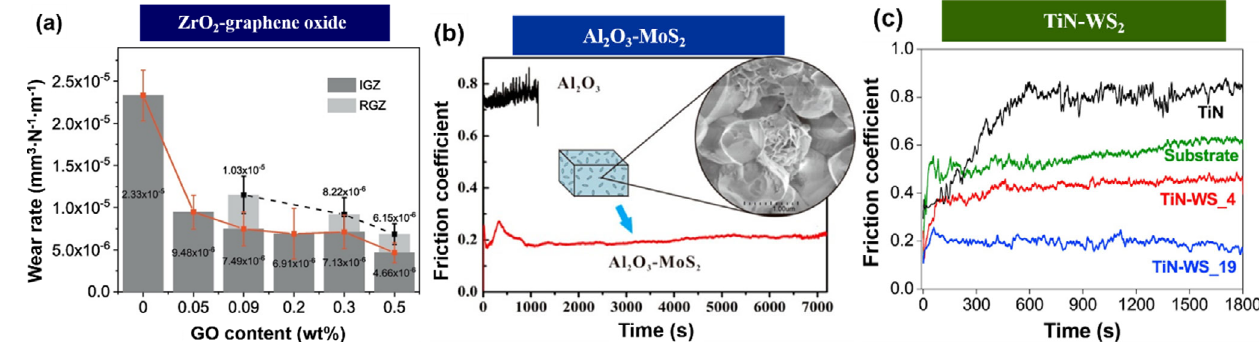
Fig. 11 (a) Specific wear rates of ZrO 2 and ZrO 2 –GO (IGZ: in situ reduced graphene oxide reinforced 3 mol% yttria stabilized zirconia; RGZ: Pre-reduced graphene oxide reinforced 3 mol% yttria stabilized zirconia). Reproduced with permission from